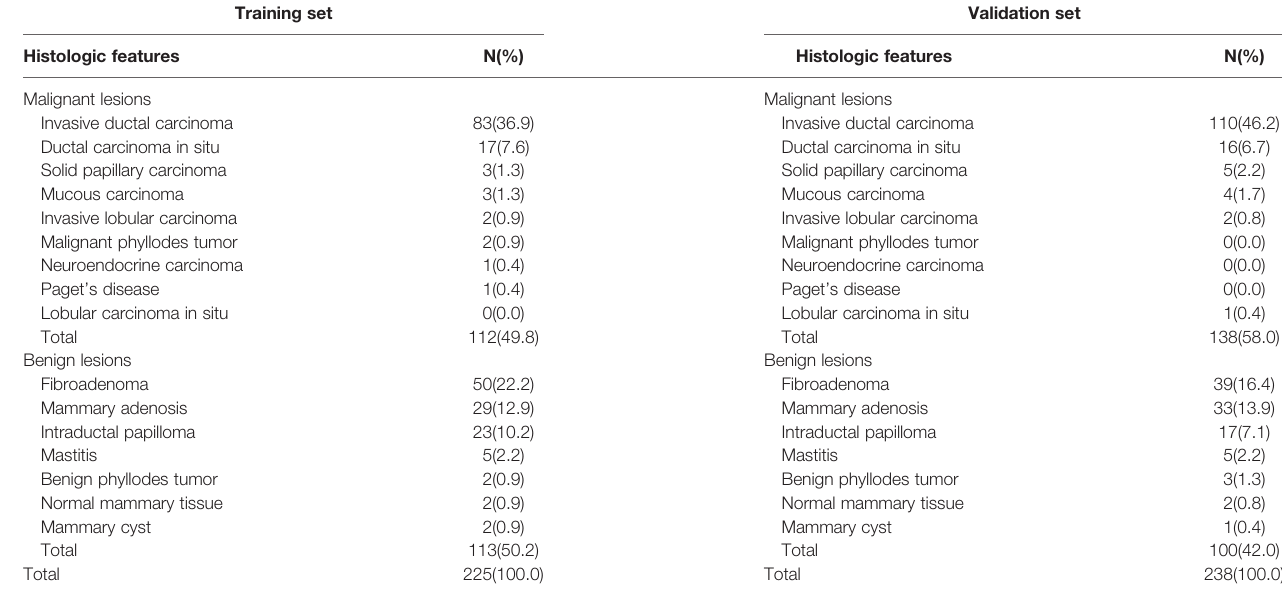
TABLE 1 | Histological diagnosis of the lesions con fi rmed by pathology in training set and validation set. Training set